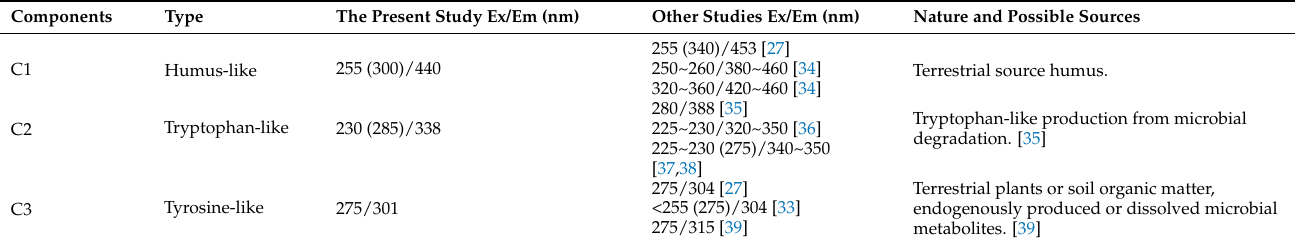
Table 2. Characteristics of the fluorescence components of DOM in the drip water of Daxiao Cave.